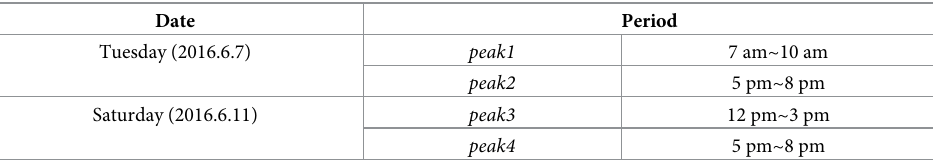
Table 1. Time period definition.